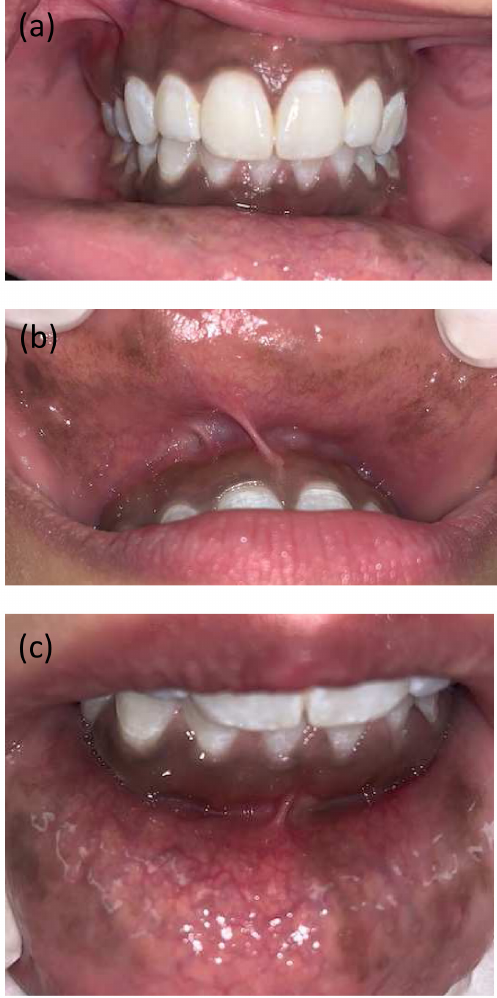
Figure 1. Clinical photographs of oral melanoacanthoma. Macular brown pigmentation with irregular margins involving ( a ) upper and lower attached and free gingivae; ( b ) upper labial mucosa; ( c ) lower labial